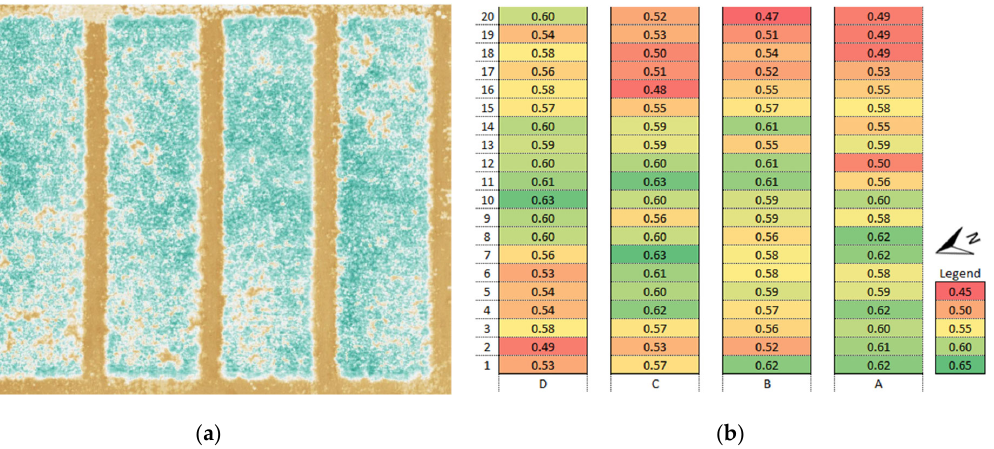
Figure 7. Orthomosaic of NDYI values from the multispectral UAV survey from 1 May 2020 ( a ) and average NDYI values calculated for individual plots of the field trial ( b